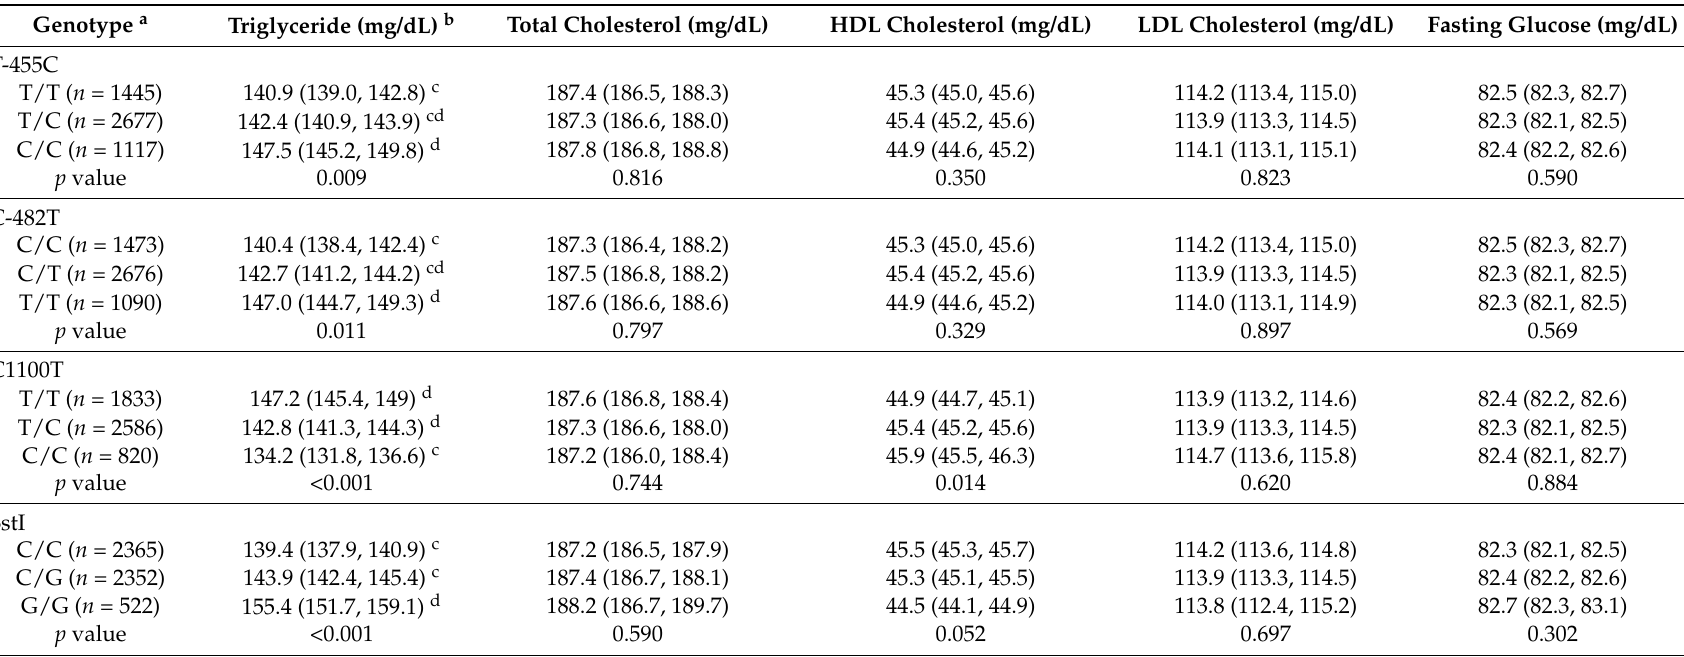
Table 2. Biochemical parameters of the population according to APOC3